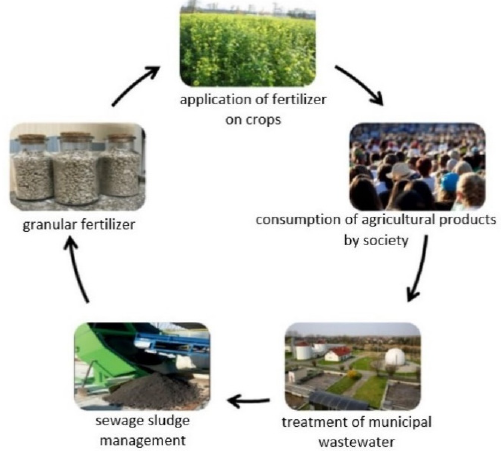
Figure 1. An example of sewage sludge management in a circular economy.